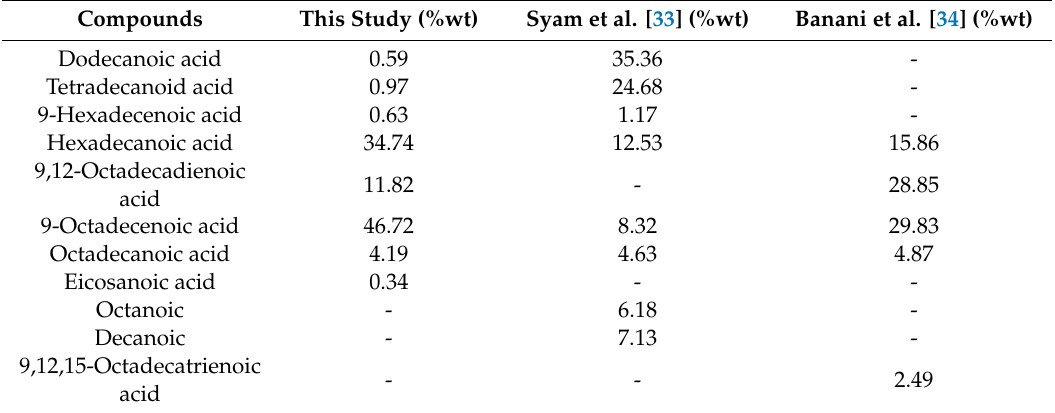
Table 5. Results of Gas Chromatography–Mass Spectrometry (GCMS) analysis of used cooking